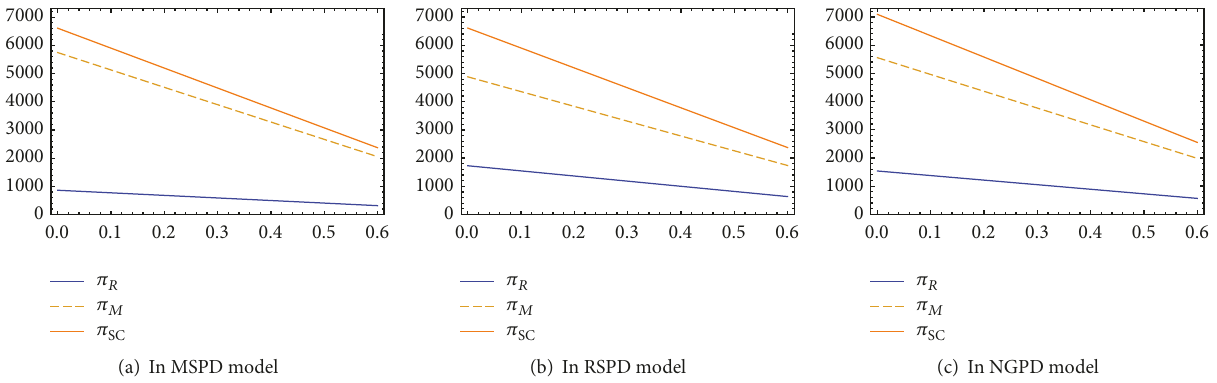
Figure 2: The change of the expected profits with the parameters 𝜀 .